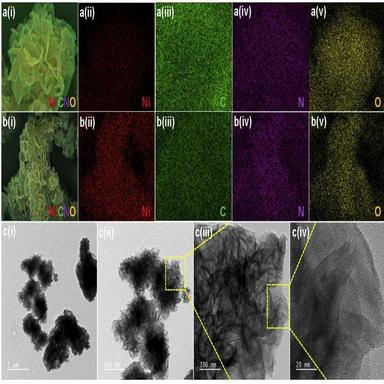
Electrochemical characterization of Ni-MOF, Ni-MOF-1, Ni-MOF-2, and Ni-MOF-3 electrodes (a) Comparative CVs of Ni-MOF, Ni-MOF-1, Ni-MOF-2, and Ni-MOF-3 electrodes at a scan rate of 2 mV/s, (b) Percentage contributions of intercalation and capacitive charge storage for Ni-MOF, Ni-MOF-1, Ni-MOF-2, and Ni-MOF-3 electrodes, (c) Intercalation and Capacitive charge contributions of the CV of Ni-MOF-2 at a scan rate of 2 mV/s, (d) Comparative GCD profiles of Ni-MOF, Ni-MOF-1, Ni-MOF-2, and Ni-MOF-3 electrodes at a